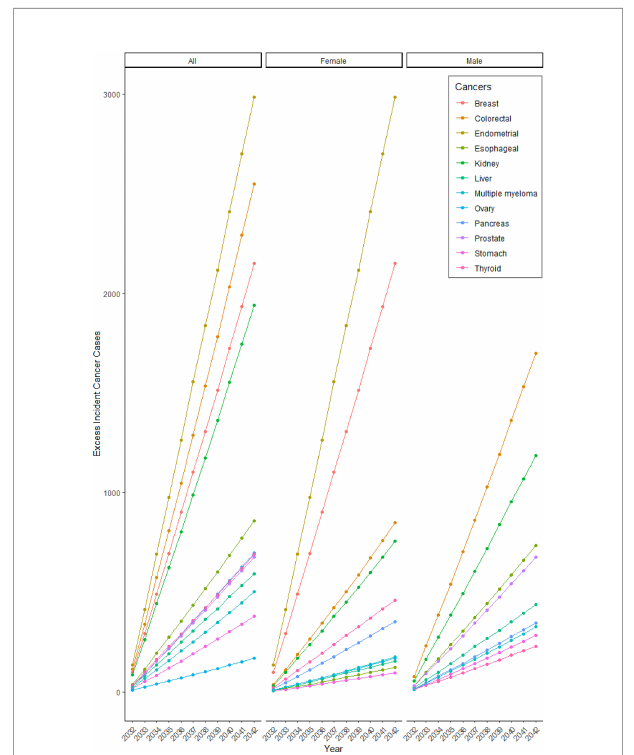
FIGURE 2 | Projected cumulative excess incident cancer cases due to changes in BMI in 2020/21. The number of cumulative excess incident cancer cases projected each year due to excess burden attributed to pandemic- related changes in BMI in